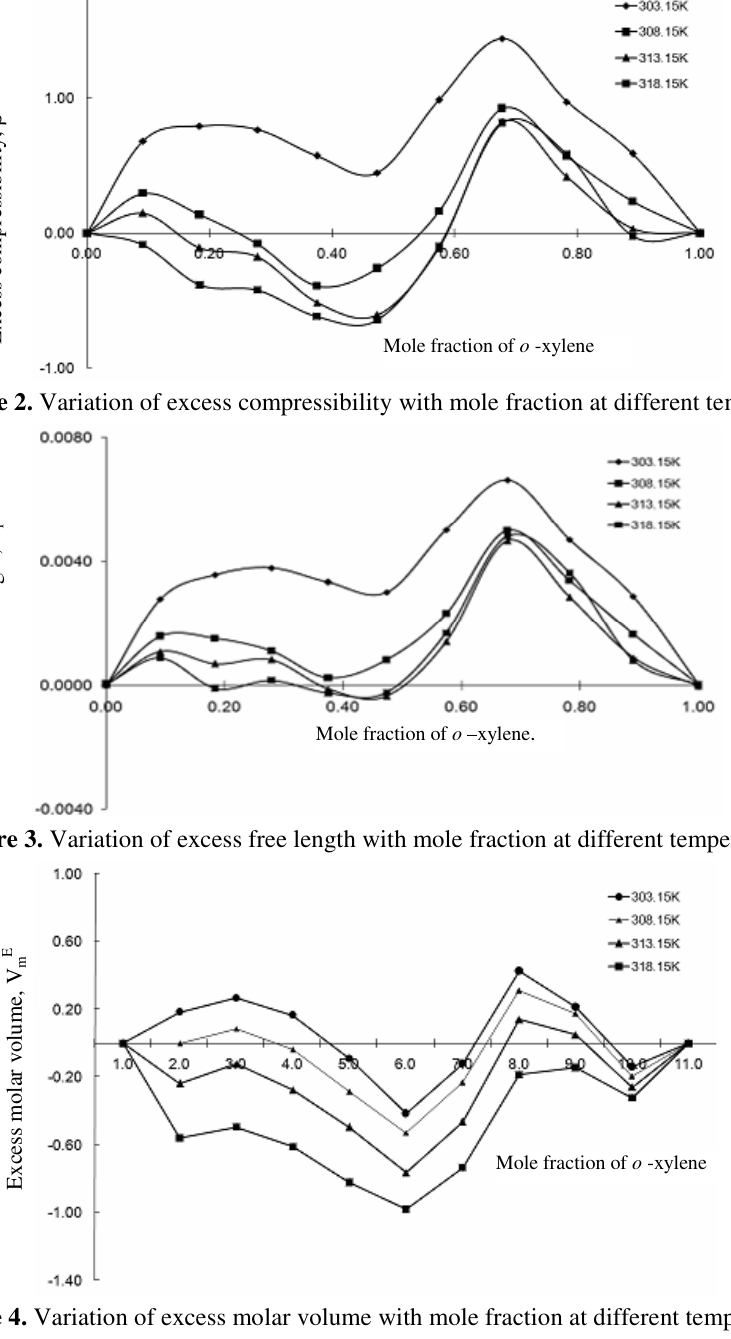
Figure 4. Variation of excess molar volume with mole fraction at different temperatures.